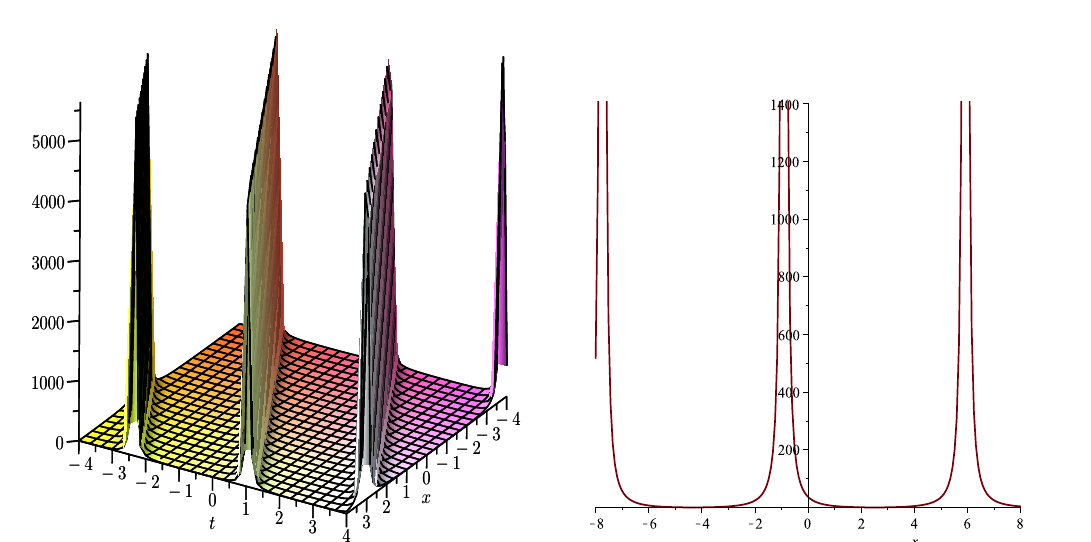
Figure 5. ( left ) 3D representation of solution (36) for ν = 1.5, κ = 0.5, ω = 1, ρ = 0, r = 1.2, p = 1, d = x , t ξ 0 = 1.5 and 4 4. ( right ) 2D representation of solution (36) for t = 2 and − ≤ ≤ periodic singular soliton.